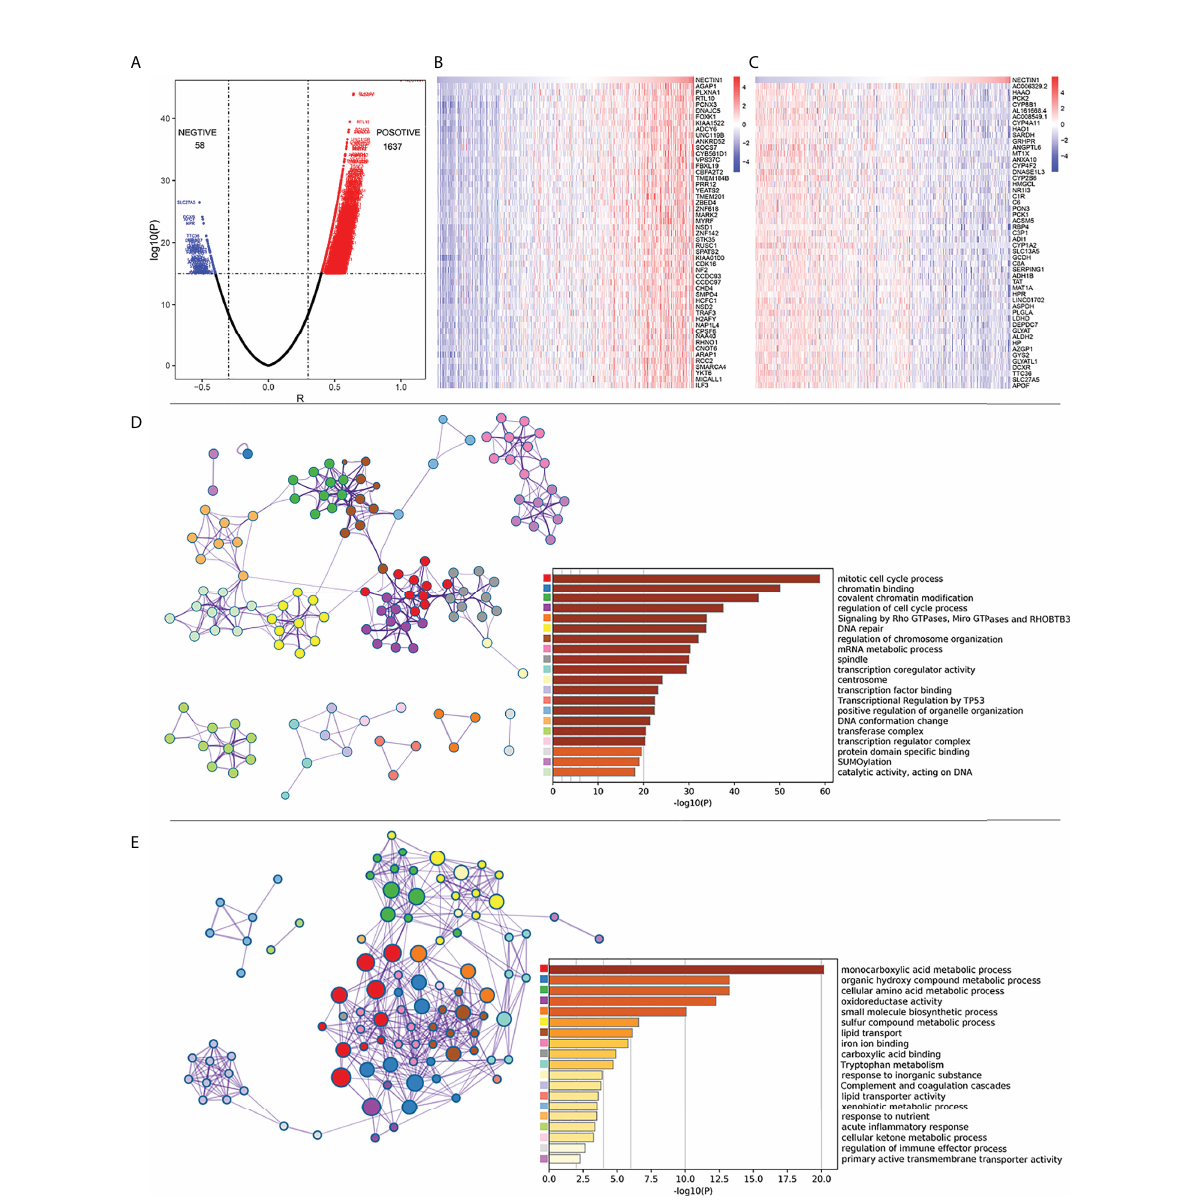
FIGURE 5 Correlation analysis of coexpressed genes between nectin-1 and HCC tissues. (A) Volcano diagram of nectin-1 and coexpressed gene. (B) Analysis of the 50 most positively correlated coexpression genes of nectin-1. (C) Analysis of 50 most negatively correlated coexpression genes of nectin-1. (D) Gene functional enrichment analysis of nectin-1 positively related genes by Metascape. (E) Gene functional enrichment analysis of nectin-1-negative correlation gene by